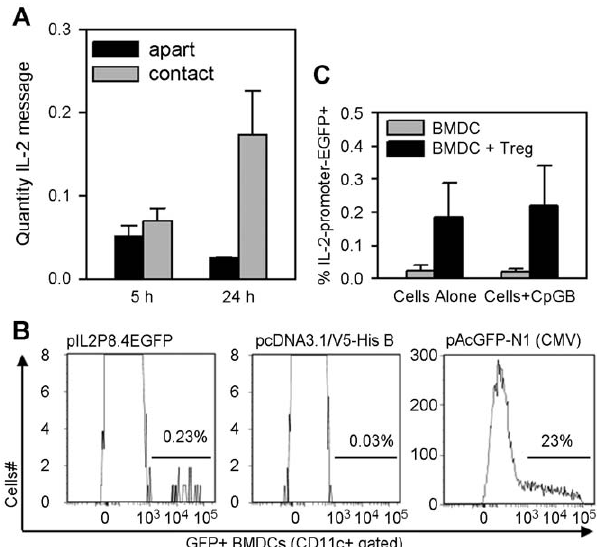
Figure 3. Tregs preserve dendritic cell transcription of IL-2. A: DO11.10 Tregs and C57BL/6 splenic DCs were cultured together or in separate tubes for 5 and 24 h, IL-2 message was measured in cultured cells by RT-qPCR as in materials and methods. Bars are the mean 6 SE of IL-2 message in the cultures. Statistical analysis was by one-way repeated measures ANOVA and Tukey’s test for all pairwise multiple comparison procedure. B&C: BMDCs were transfected with the IL-2 reporter plasmid (pIL2P8.4-EGFP), a negative control plasmid (pcDNA3.1/V5-His B), and a positive control plasmid to assess transfection efficiency (pAcGFP-N1). Transfectants were analyzed for IL-2-promoter activity in cells as in materials and methods. B: Panels show histograms of the level of promoter-driven GFP in gated CD11c + cells. The experiment was repeated with similar results. C: pIL-2P8.4- EGFP-transfected BMDCs were cultured unstimulated or with CpG-B, with and without Treg cells for 40 h. Bars are the mean 6 SE of IL-2- promter-EGFP + BMDCs from two